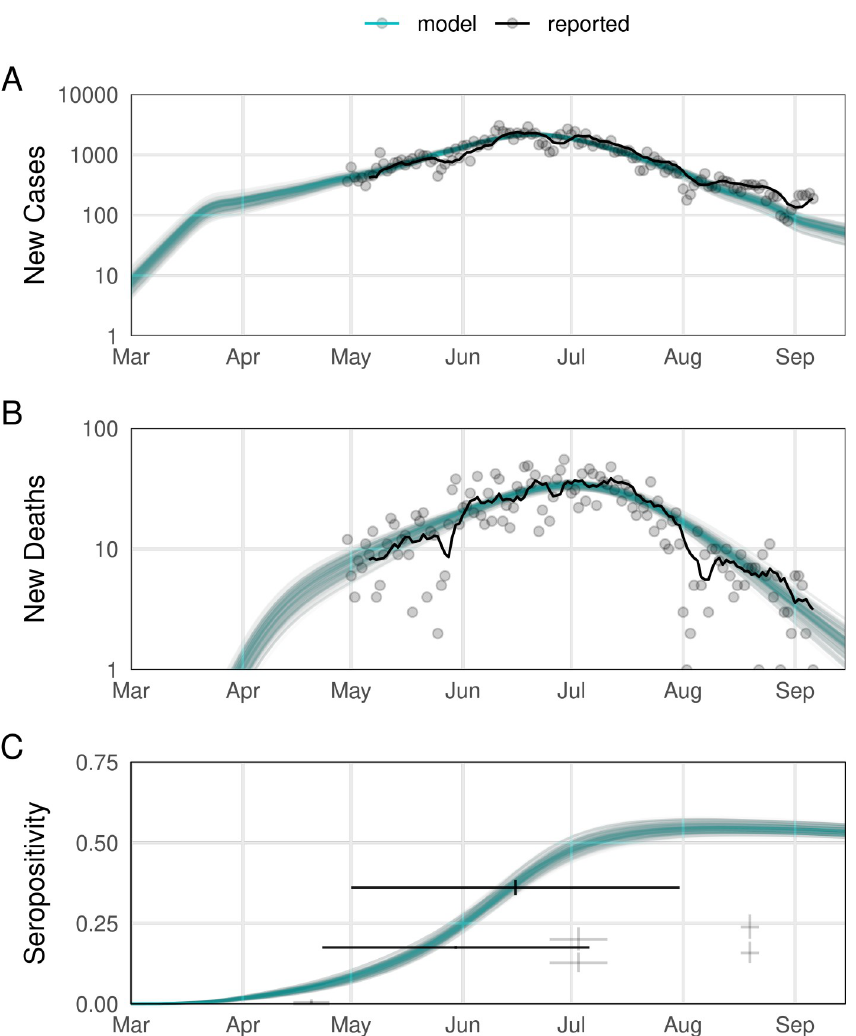
Fig 1. Outcomes for fitted model ascertained outcomes compared to data. Sample ascertained trajectories ( n = 250) from the posterior of model parameters (blue) compared to observed outcomes (black). For observed cases and deaths, the solid line is the 7-day average, with points corresponding to daily reports. For the limited serological data, the crosshairs show the collection period and binomial confidence interval on the seropositivity estimates. The serial study results with expected low seropositivity are faded. Expected duration of infection-derived immunity assumed to be 2.5 years; other immunity assumptions in Fig C in S1 Text. All of the assumptions considered produce comparable fits to reported cases and deaths through September